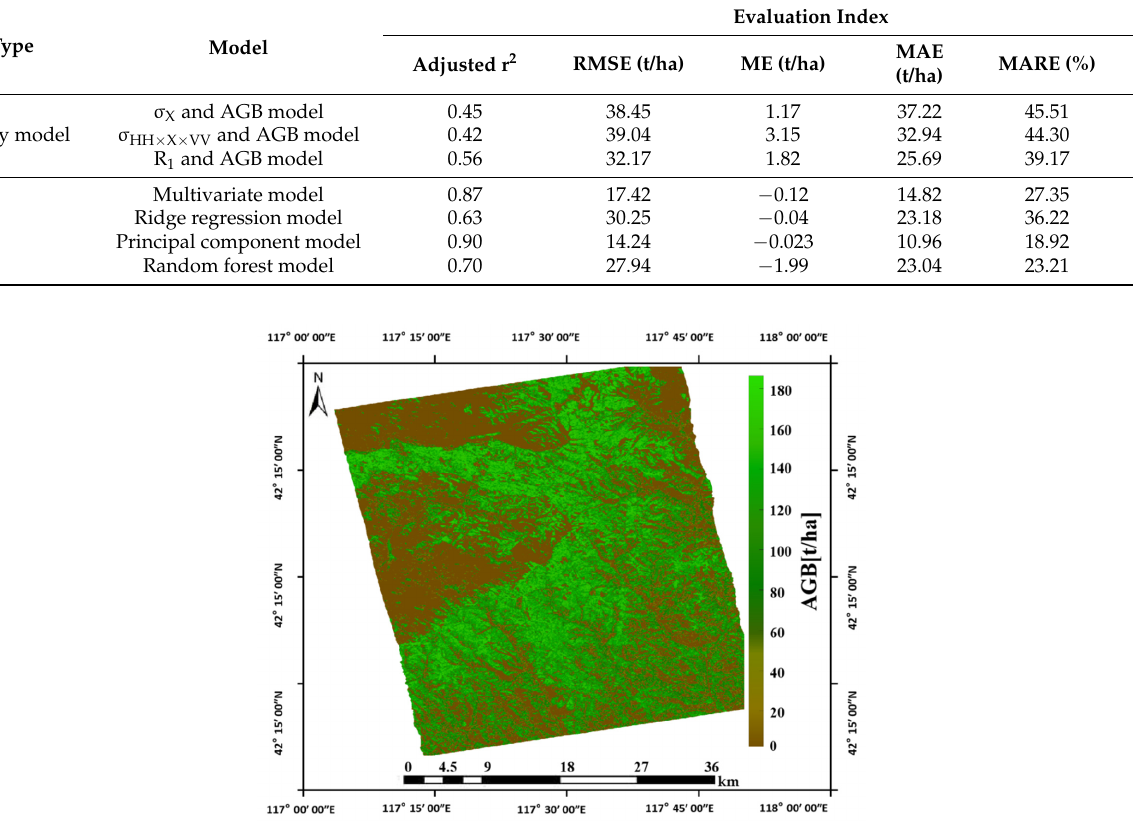
Figure 11. AGB prediction results.